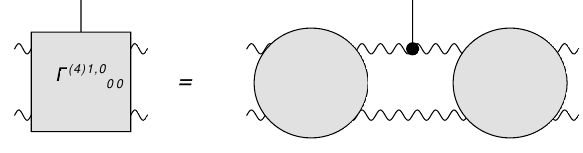
Figure 16 . Identity for the 5-point function.